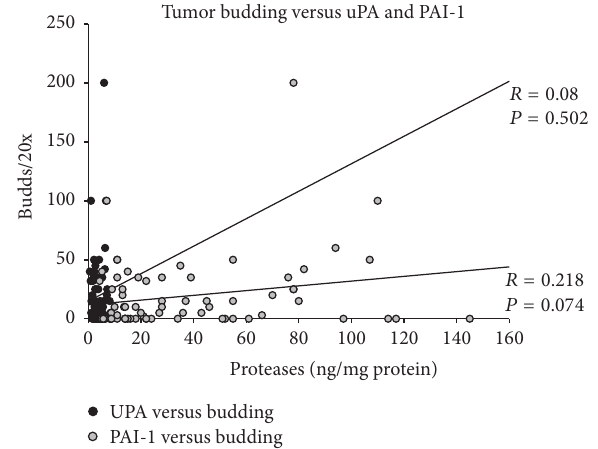
Figure 2: Correlation between tumor budding and uPA and